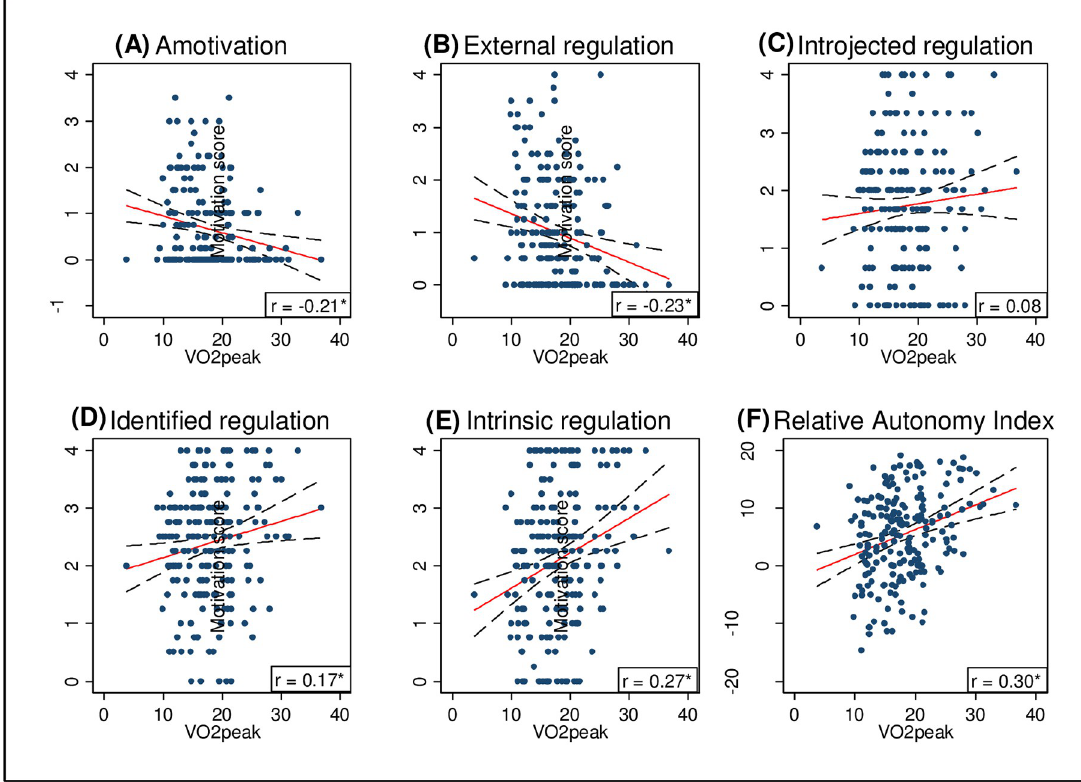
Fig 1. Correlation between different constructs of motivation and VO2peak with Spearman coefficient (r). (A) Amotivation: relationship between amotivation score and VO 2peak . r = -0.21 � ; (B) External regulation: relationship between external regulation and VO 2peak . r = 0.23 � ; (C) Introjected regulation: relationship between introjected regulation and VO 2peak . r = 0.08; (D) Identified regulation: relationship between identified regulation and VO 2peak . r = 0.17 � ; (E) Intrinsic regulation: relationship between intrinsic regulation and VO 2peak . r = 0.27 � ; (F) Relative autonomy index: relationship between relative autonomy index and VO 2peak . r = 0.30 � . Significance: � P < 0.05.